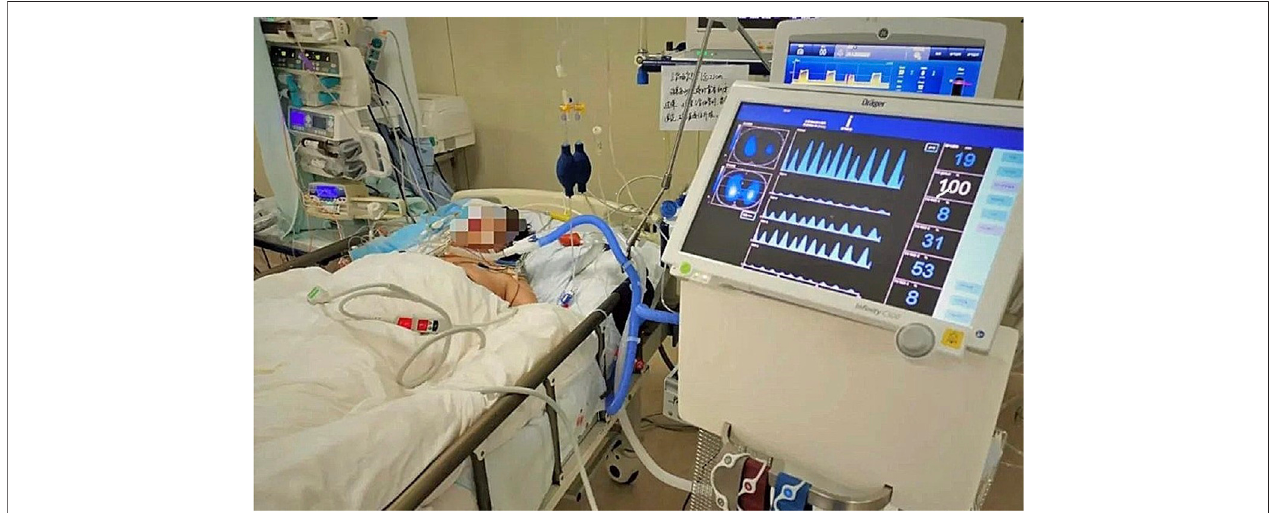
FIGURE 8 | Real-time monitoring of lung disease patients by EIT. Through the EIT equipment, in some clinical pathological treatments, the patient ’ s pulmonary function imaging and the patient ’ s long-term bedside continuous monitoring can be achieved.